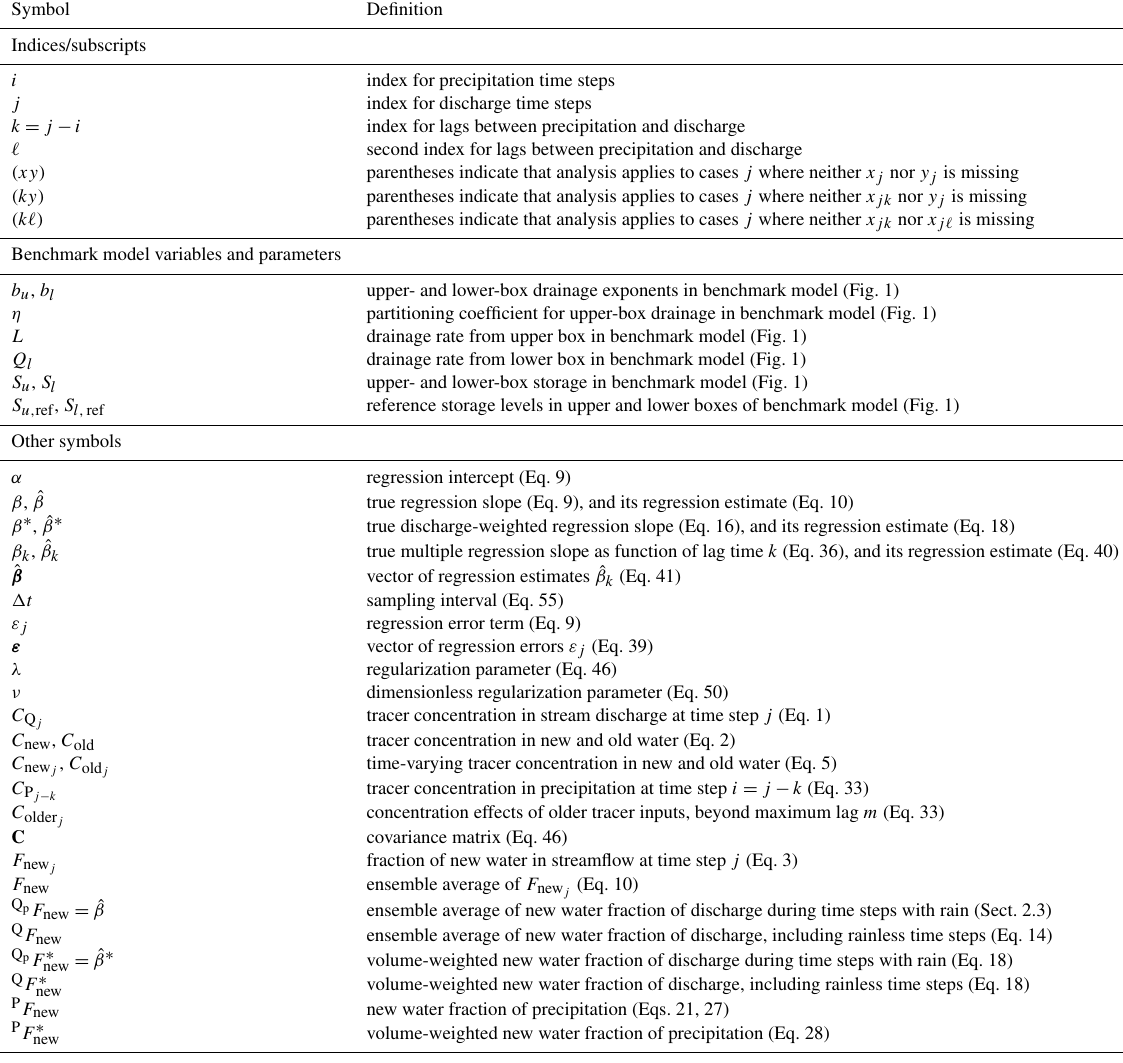
Table C1. Definition of symbols (with defining equation, or equation of first use, in